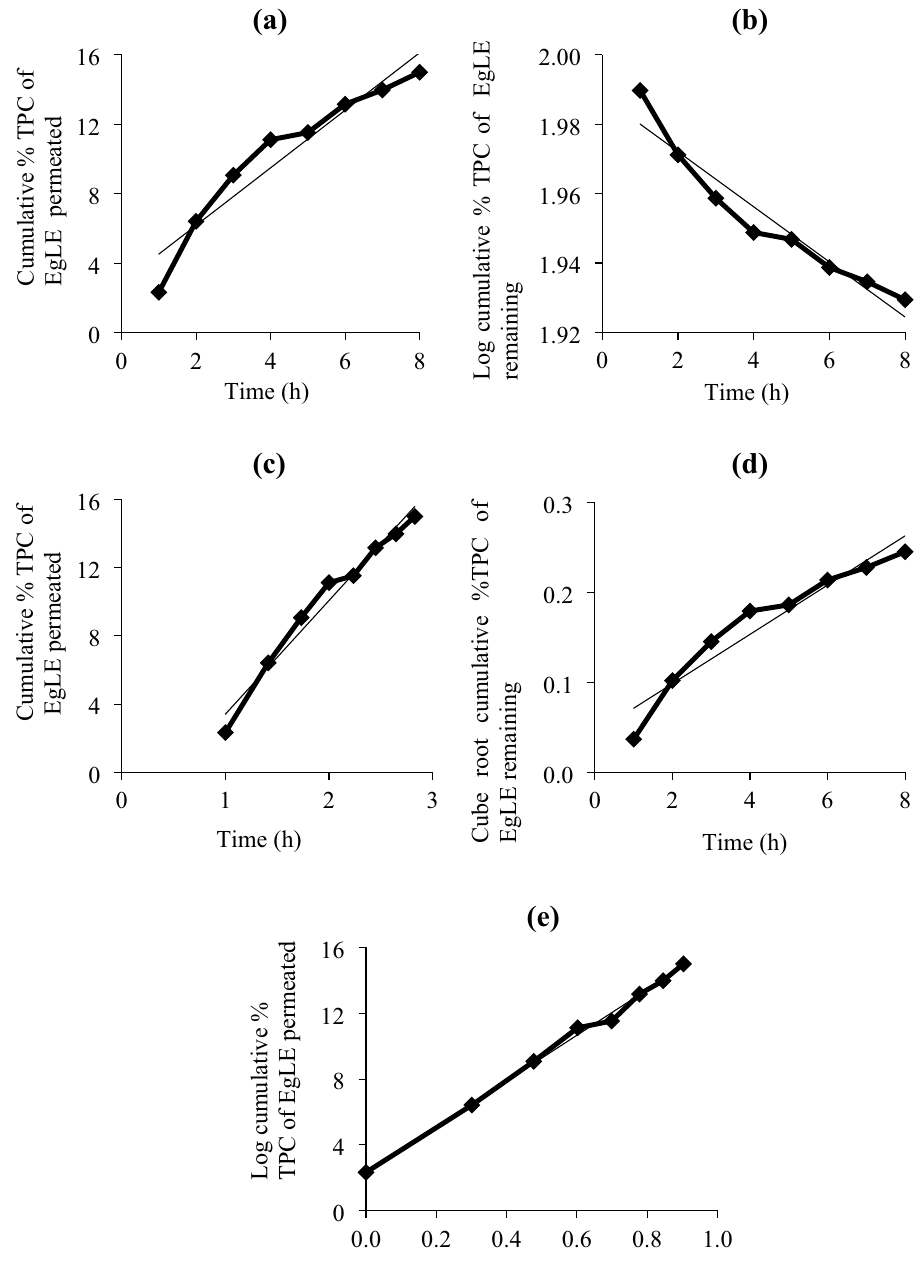
Figure 6. Graph for ( a ) zeroth order, ( b ) first-order, ( c ) Higuchi, ( d ) Hixson–Crowell, and ( e ) Korsmeyer– Peppas for the kinetic release of the TPC of EgLE from the optimal